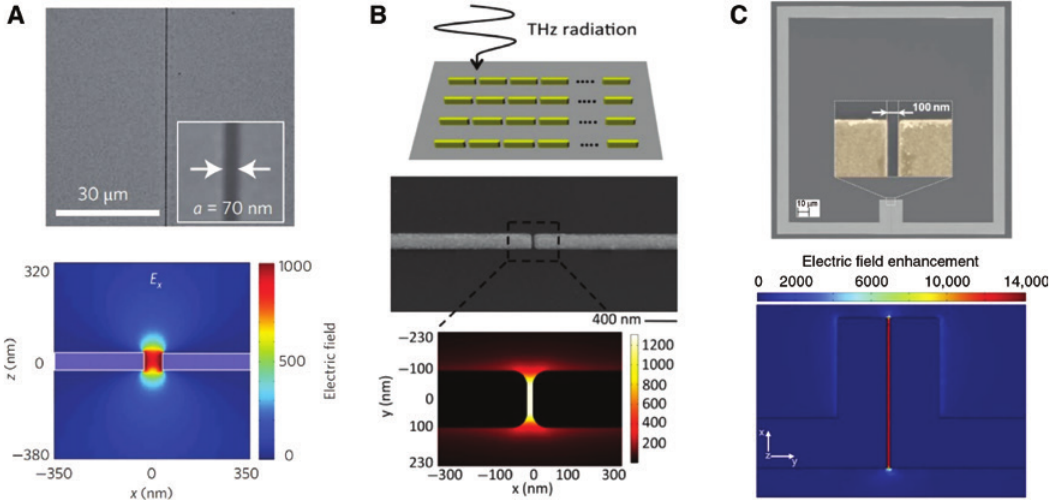
Figure 2: THz field enhancements in various gap structures. (A) Nanogap in metal plate, (B) nanogap in rod antennas, and (C) split-ring resonators. A, B, and C are reproduced from Refs. [69], [101], and [162], respectively.